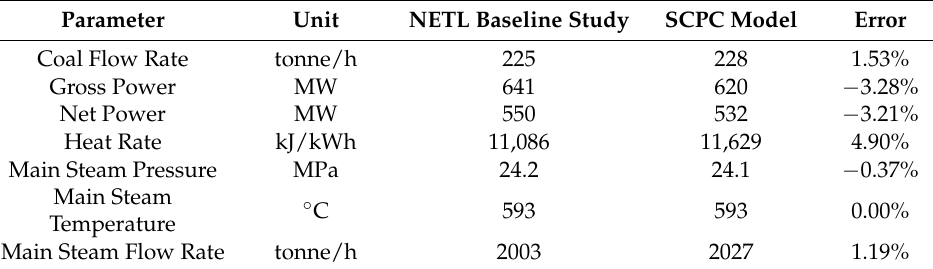
Table 2. Steady-State Validation for Full Load.